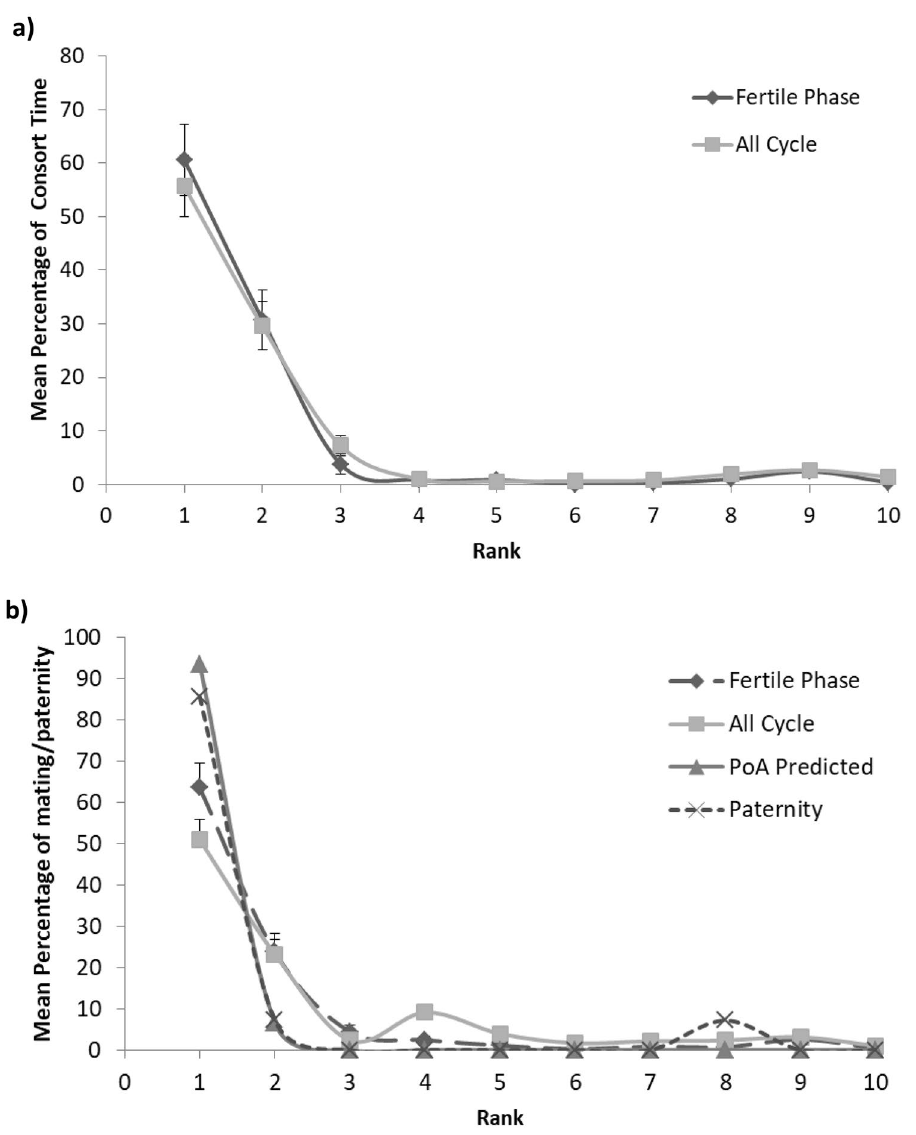
Figure 2. Percentage of consort time ( a ) and matings and paternity ( b ) obtained by males of each rank for the whole 14 day period, and the 4 day fertile period, separately (mean and standard deviation). The mating and paternity plot ( b ) also includes the percentage predicted under the PoA model and the percentage of infants